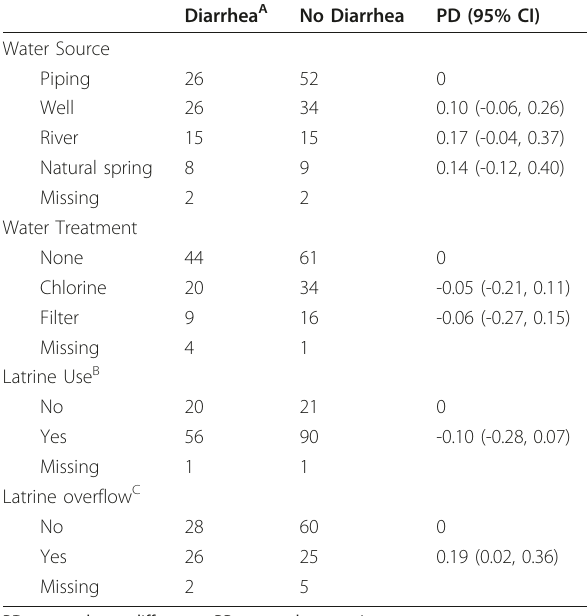
Table 4 Linear regression models of the relationship between latrine use, latrine overflow, and diarrhea A in the North Atlantic Autonomous Region, Nicaragua,